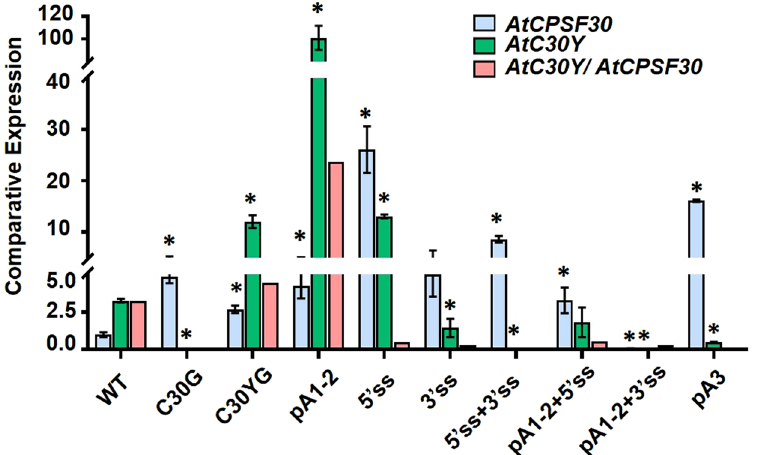
Figure 7. Comparative expression of AtCPSF30 , AtC30Y and the ratio between these two transcripts detected by quantitative RT-PCR. The experiment was performed on at least three biological repeats from T2 generation, and representative results were shown. Bars represent means + / − SD. Two-tail t -test results are indicated by ( * ) with p < 0.05. The significant differences were all compared to the wild type